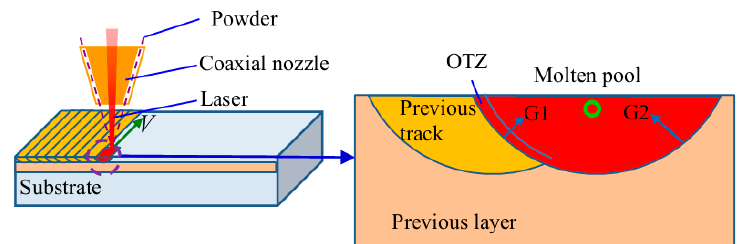
Figure 12. Schematic illustration of the temperature gradient, G, and growth rate, R, distribution in the molten pool during the LAR process.